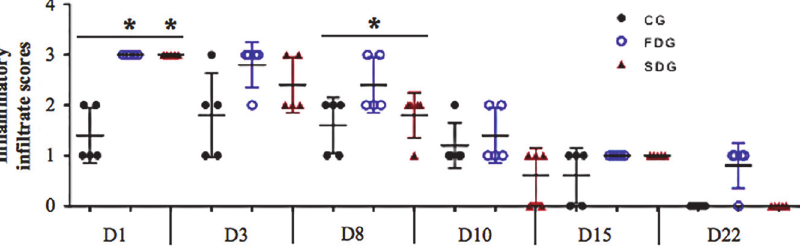
Fig 4. Inflammatory infiltrate score — SDG exhibited more leukocytes than other groups through to Day 10.